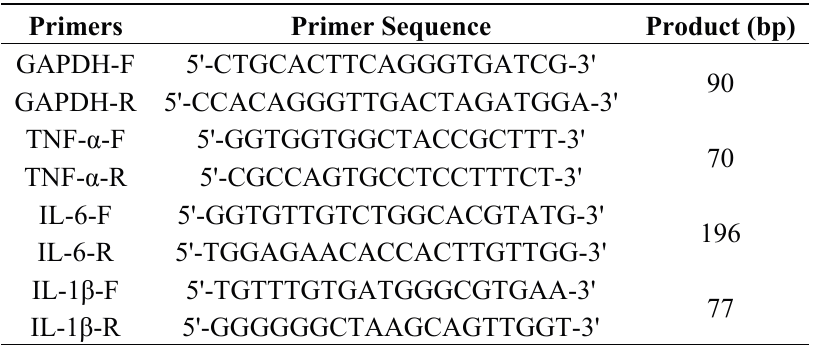
Table 1. RT-PCR detection of TNF- α , IL-6 and IL-1 β gene